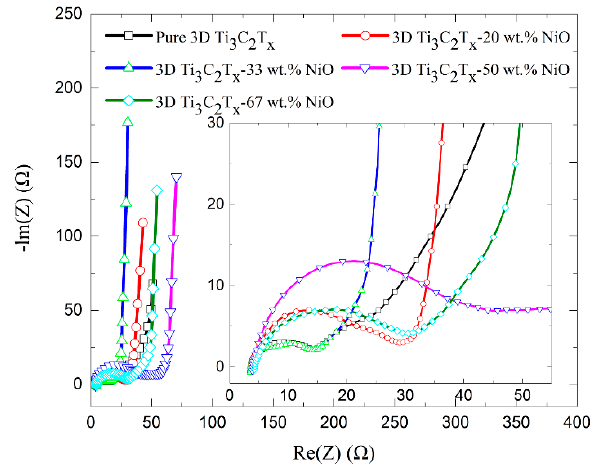
Figure 4. Nyquist plots of pure 3D porous Ti 3 C 2 T x and 3D porous Ti 3 C 2 T x -NiO